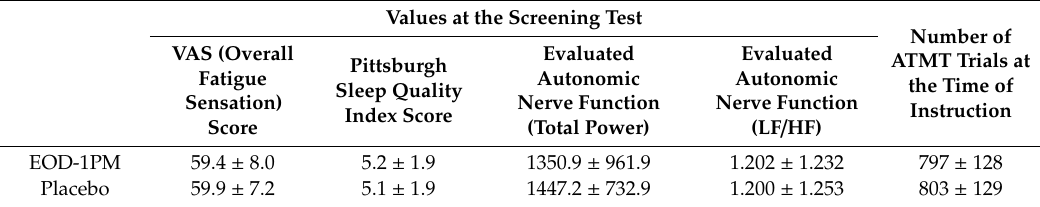
Table 2 Subject backgrounds (test score and evaluated autonomic nerve function). Table 2. Subject backgrounds (test score and evaluated autonomic nerve function). Values at the Screening